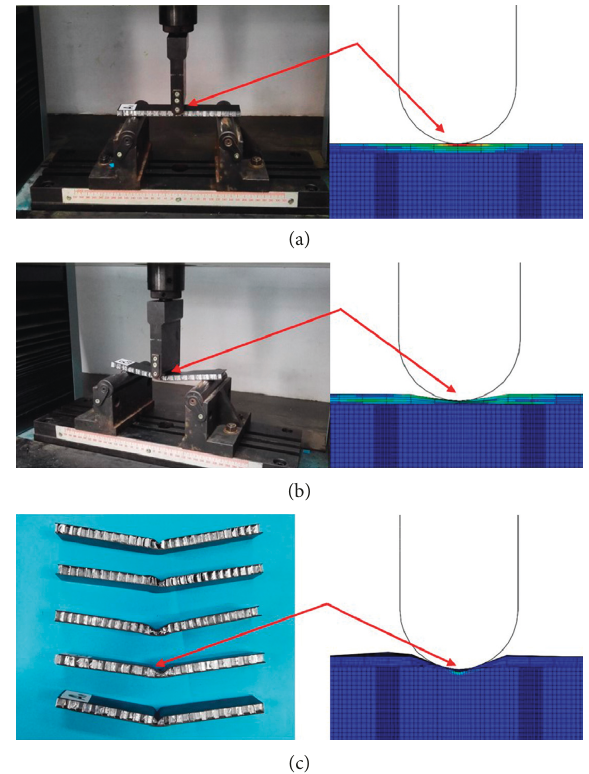
Figure 10: The failure process of sandwich panels in three-point bending tests.